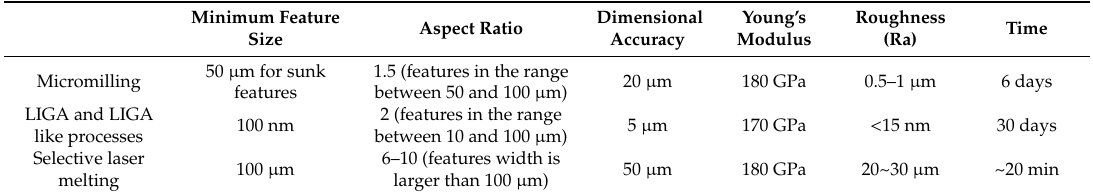
Table 2. Comparison of the fast mould tool prototyping